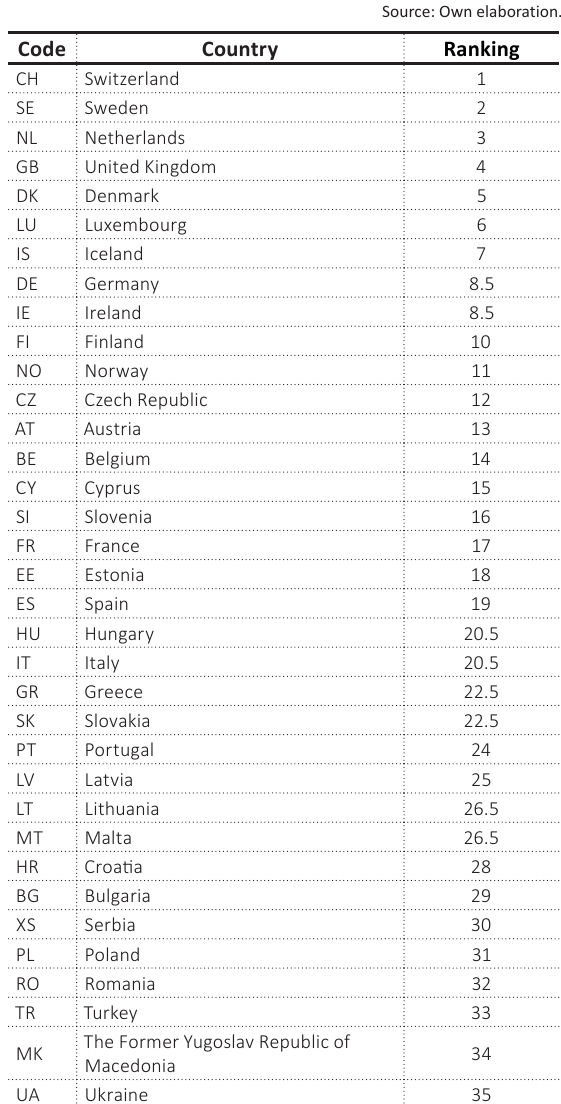
Table 4. Ranking of the innovation activity of countries in 2017, created on the basis of features adopted for the study (the SII is not taken into account)